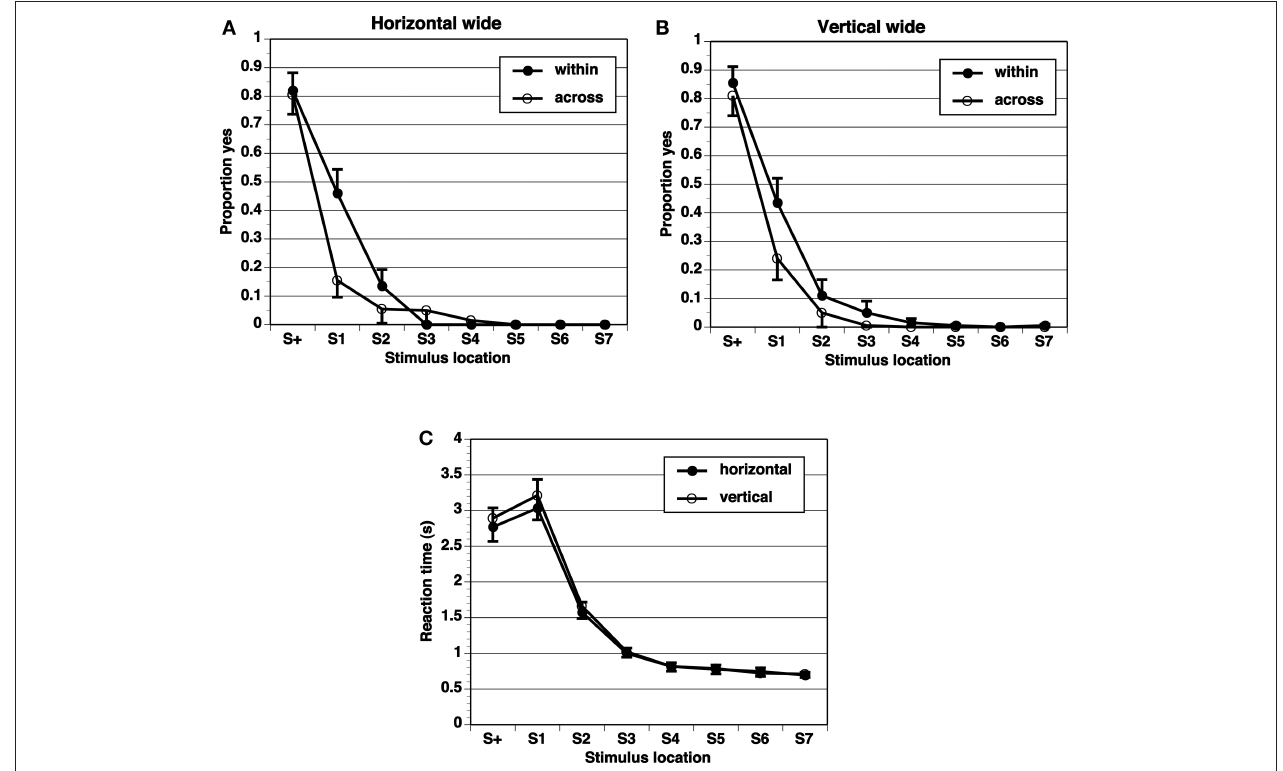
Figure 5 | Proportion of “yes” responses (A, B, M ± SeM) and reaction times (C, M ± SeM) in Wide-8 experiment, with wide spacing between stimulus locations and eight test